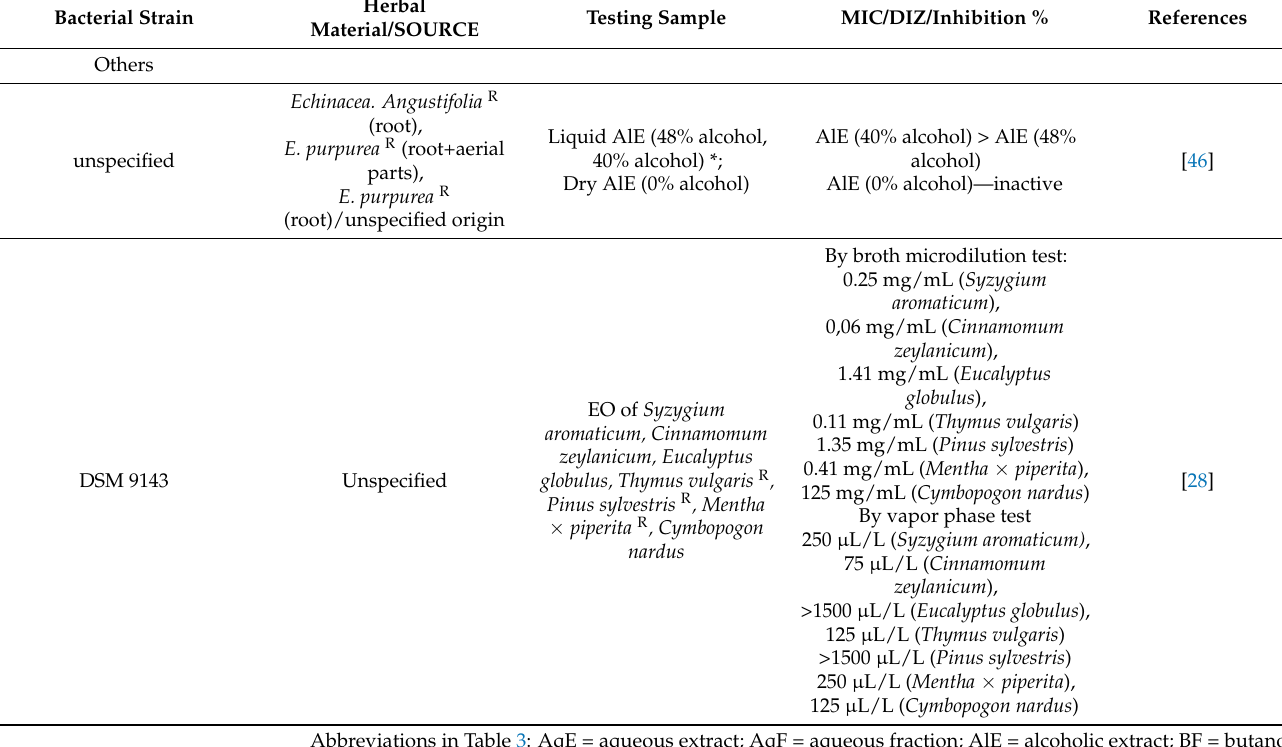
Abbreviations in Table 3: AqE = aqueous extract; AqF = aqueous fraction; AlE = alcoholic extract; BF = butanol fraction; CF = chloroform fraction; DeeE = diethyl ether extract; DeeE = diethyl ether fraction; EaF = ethyl acetate fraction; HE = hexane extract; HF = hexane fraction; ME = methanolic extract. All extracts are dry extracts, except those marked with “*” in table. EO = essential oil. “ R ” = species identified in the Romanian flora